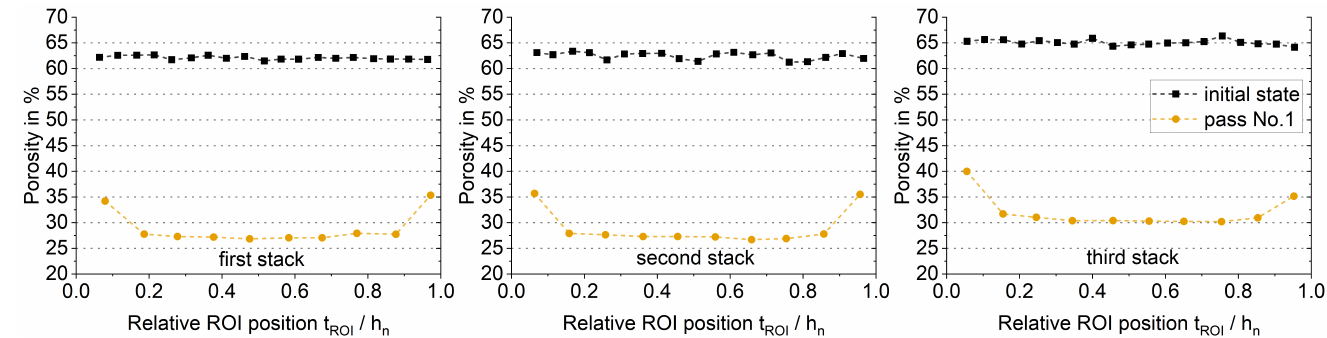
Figure A4. Series II: 5-0.50-1 ( l d / h m ≈ 4.2): Porosity change over relative sample depth (0=upper surface; 0.5= mid-section of sample; 1 =lower surface) due to rolling for first, second and third stack.